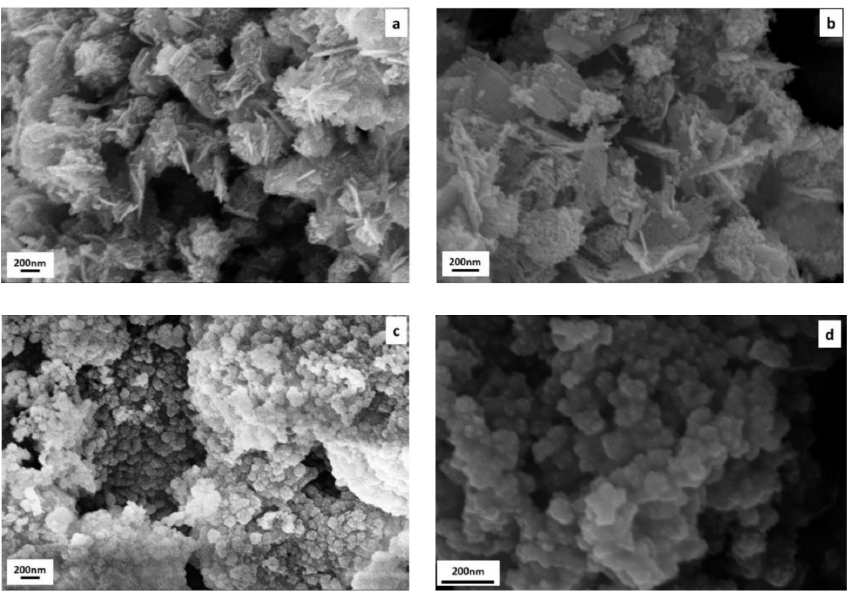
Figure 2. SEM images of ( a , b ) CuO and ( c , d ) ZnO NPs.